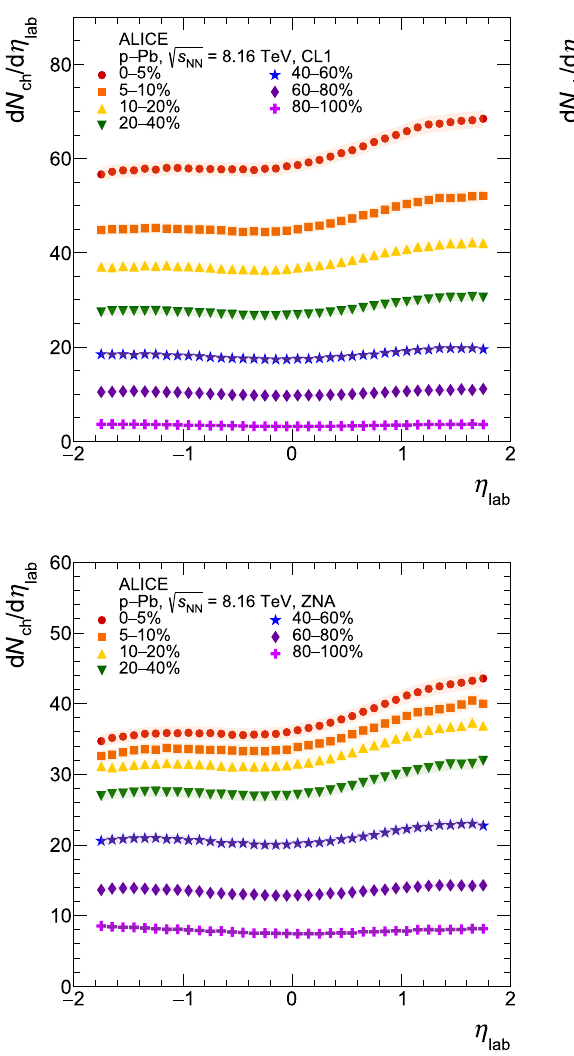
Fig. 5 Pseudorapidity density of charged particles in p–Pb NSD collisions at (top left), V0A (top right) and ZNA (bottom